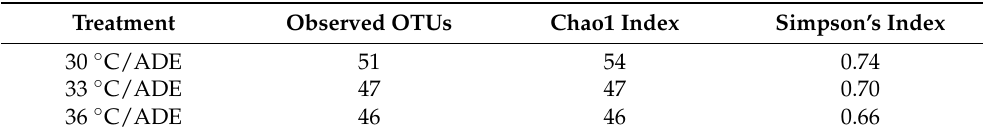
Figure 7. Taxonomic composition of bacterial communities detected during C. sorokiniana AM-02 cultivation in ADE-containing media (184 h). Bacterial community structure according to amplicon sequencing of the bacterial 16S rRNA gene is shown on the class (top row) and family (bottom row) levels. Table 3. Alpha diversity of bacterial communities in ADE-containing